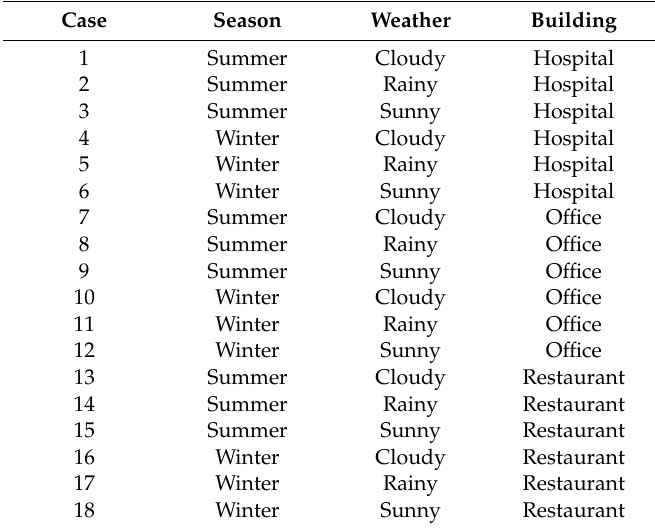
Table 1. Detailed information for each case.